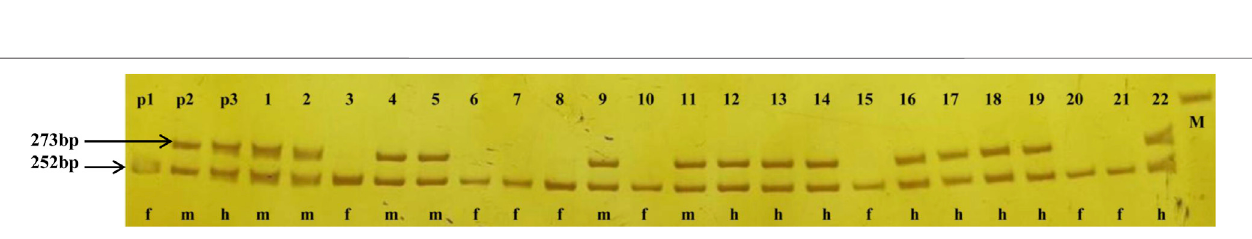
FIGURE 4| PCR ampli fi cation of the sexmarker in “ Zuoshanyi ” , “ 043 ” , “ Shuangqing ” and some individuals of the “ Z0 ” and “ ZS ” populations. p1: “ Zuoshanyi ” , p2: “ 043 ” , p3: “ Shuangqing ” , 1 – 11: 11 individuals randomly chosen from the “ Z0 ” population, 12 – 22: 11 individuals randomly chosen from the “ ZS ” population, f: female individual, m: male individual, h: hermaphroditic individual, M: 300 bp marker.